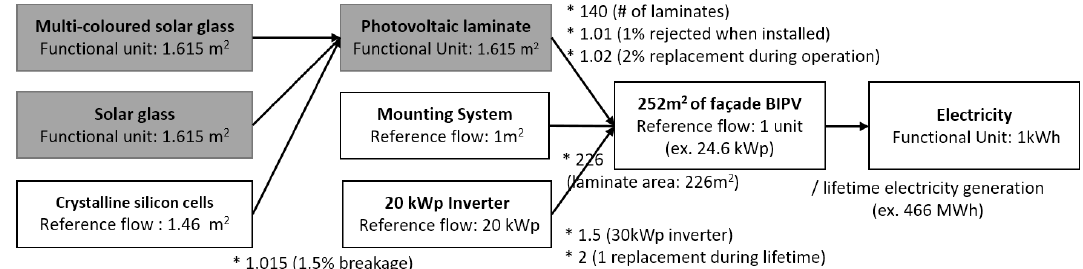
Figure 3. Configuration of an architecturally integrated 24.6 kWp photovoltaic (PV) façade facing south consisting of 140 multi coloured glass-glass (MCGG) laminates generating 466 MWh over 30 years. While a 30 kWp inverter is installed, its data is derived from that of a 20 kWp inverter scaled by a factor of 1.5. Product systems with grey background were specified from industrial data, while those with white background were derived from literature values and